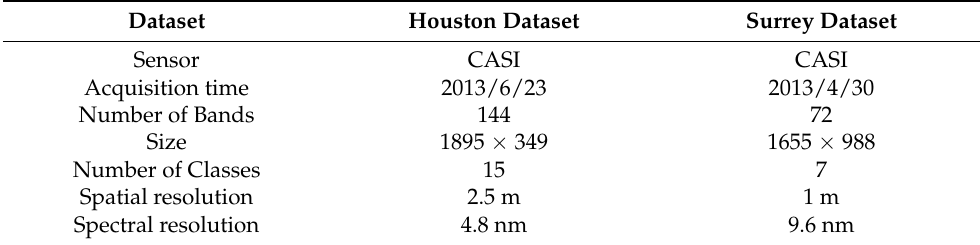
Table 2. Experimental dataset information.